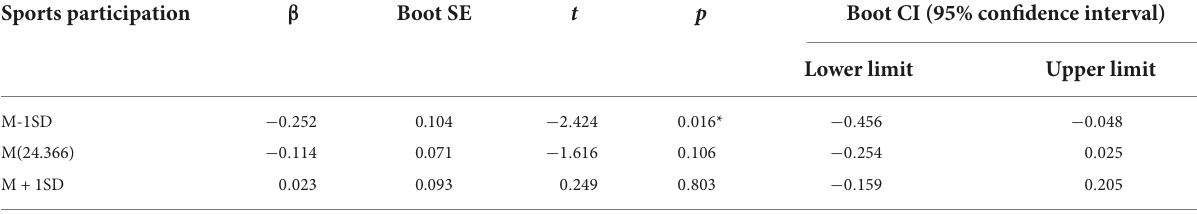
TABLE 7 Moderating effect of different levels of sports